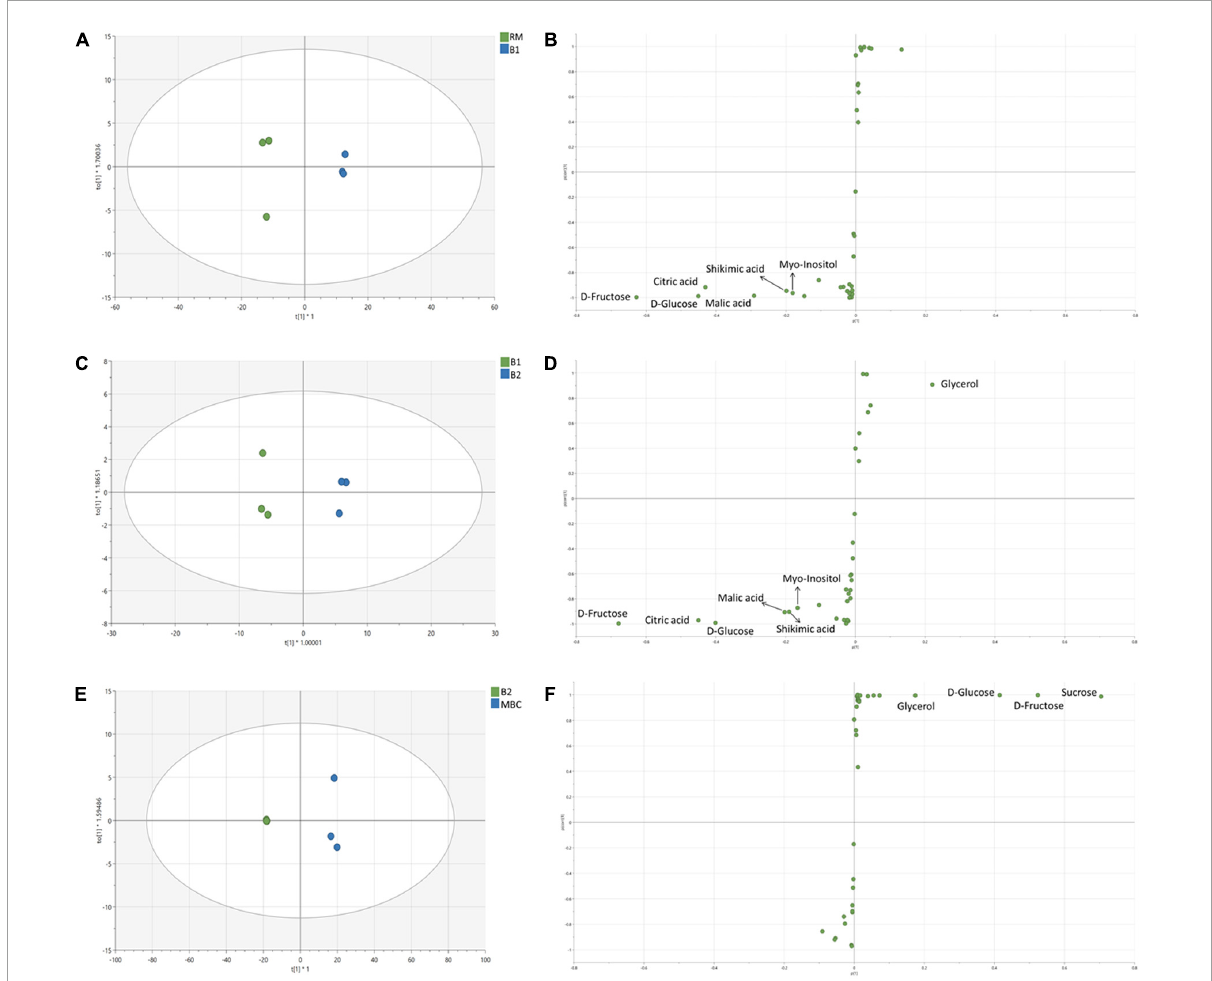
FIGURE4 OPLS-DA score plot and S-plot of non-volatile metabolites of S1 (A,B) , S2 (C,D) , and S3 (E,F) . Each dot in the score plot represents a biological